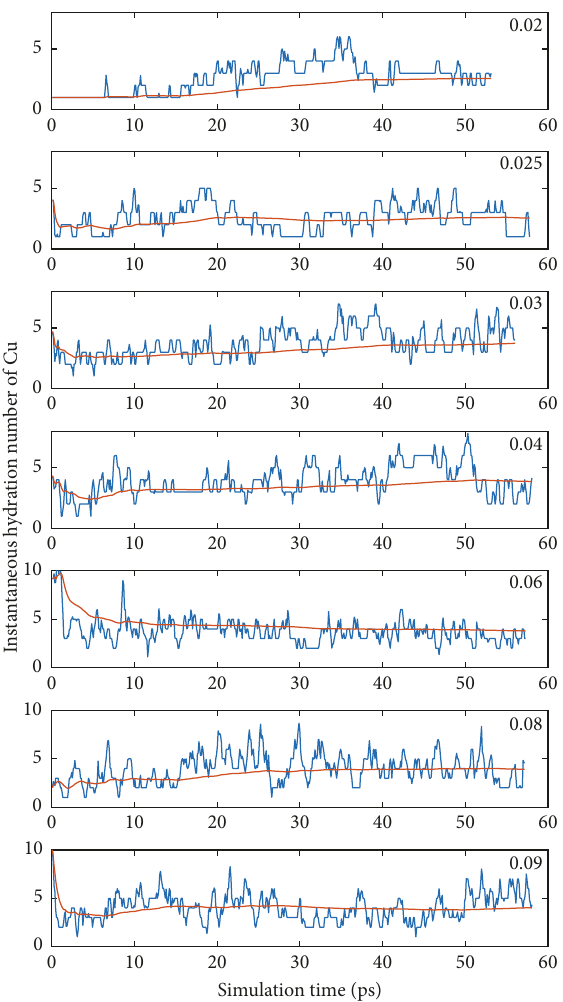
Figure 3: Dynamic hydration number of the CuCl 0 complex (within 5 ˚A of Cu) as a function of simulation time at different values of density (the density values are indicated at the top right in each